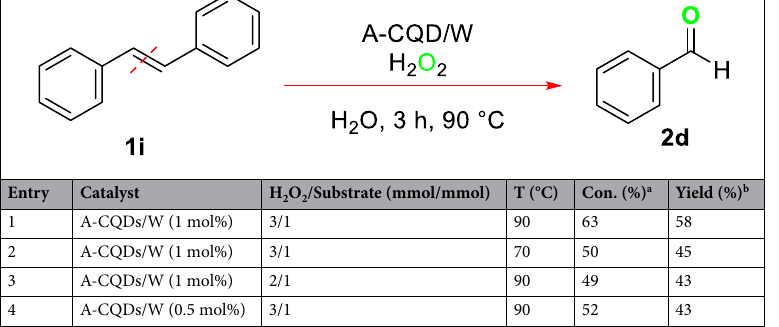
Table 2. Investigation of oxidative cleavage of trans -stilbene under optimum conditions in the presence of acidic additives. Reaction conditions: trans -Stilbene (1 mmol), H 2 O (1.5 mL), A-CQDs/W (1 mol %), 3 h. a Conversions were calculated based on initial mmol of trans -stilbene. b Isolated